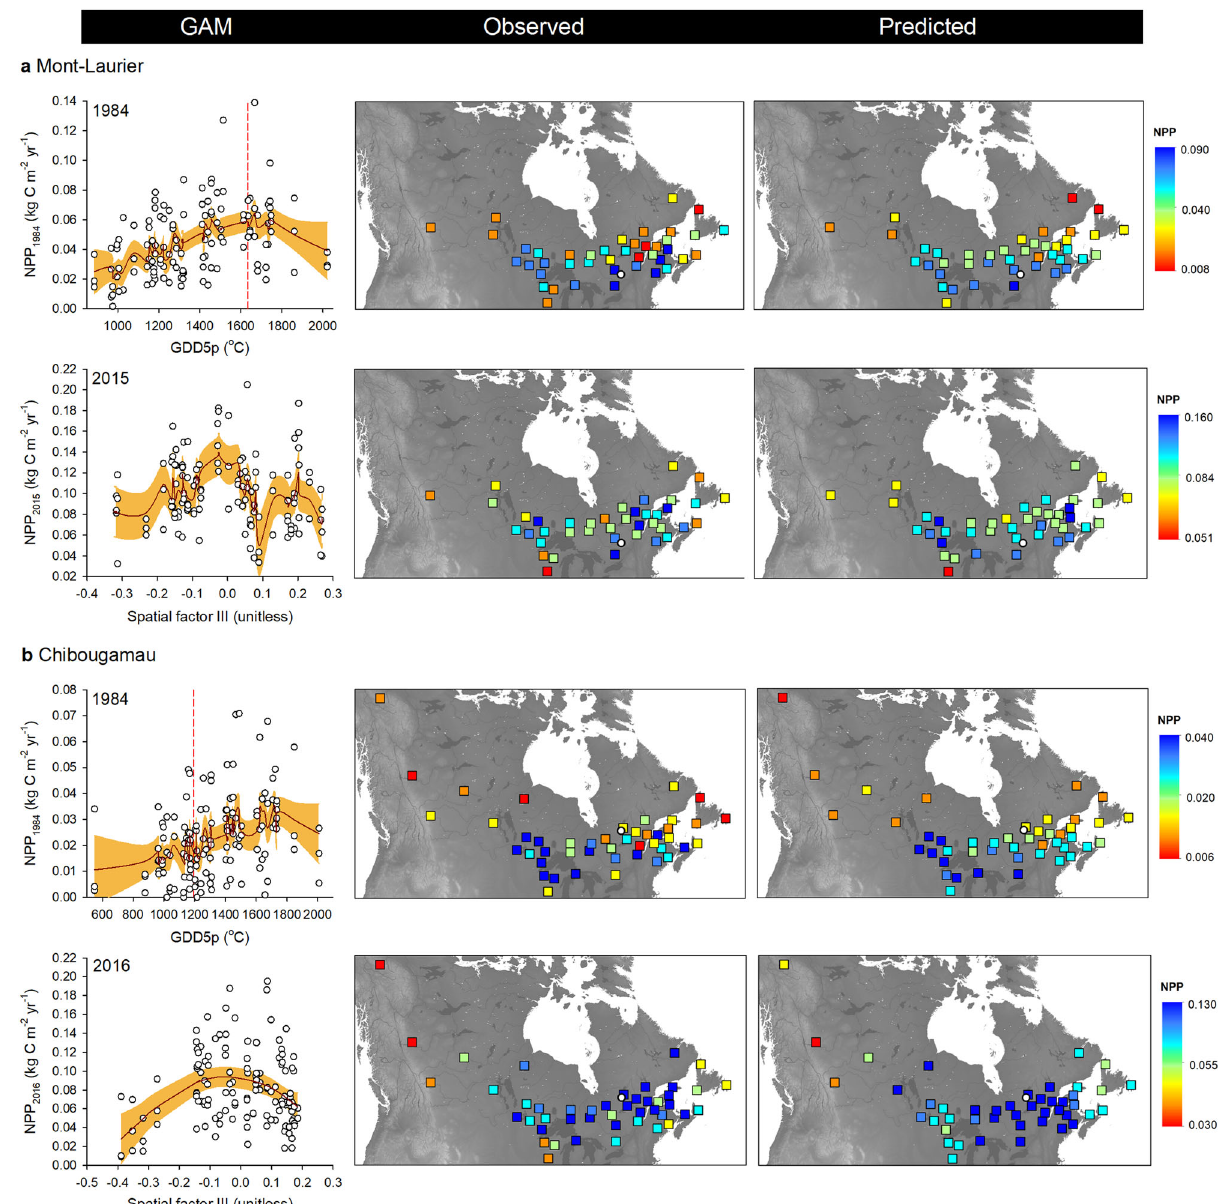
Fig. 5 Relationships between annual NPP and phenotypic GDD5p clines and spatial factors. Illustrated are the year 1984 (i.e. the 10th year after planting) and the last year of inventory (2015 for a Mont-Laurier and 2016 for b Chibougamau). Biplots at left illustrate observations (white dots) along with generalized additive model (GAM) predictions (red lines), with two-sided 95% con fi dence intervals (orange shadings). The location of the sampling sites along the GDD5p gradient is illustrated by a vertical dashed line; a provenance that has its value to the left of that line is from a cooler origin than local, and a value that is to the right denotes a warmer origin. The spatial factor illustrated here is the third one, as determined using distance-based Moran ’ s eigenvector maps. Maps at right illustrate the variability of NPP in coordinate spaces (with the location of the common garden sites illustrated by white